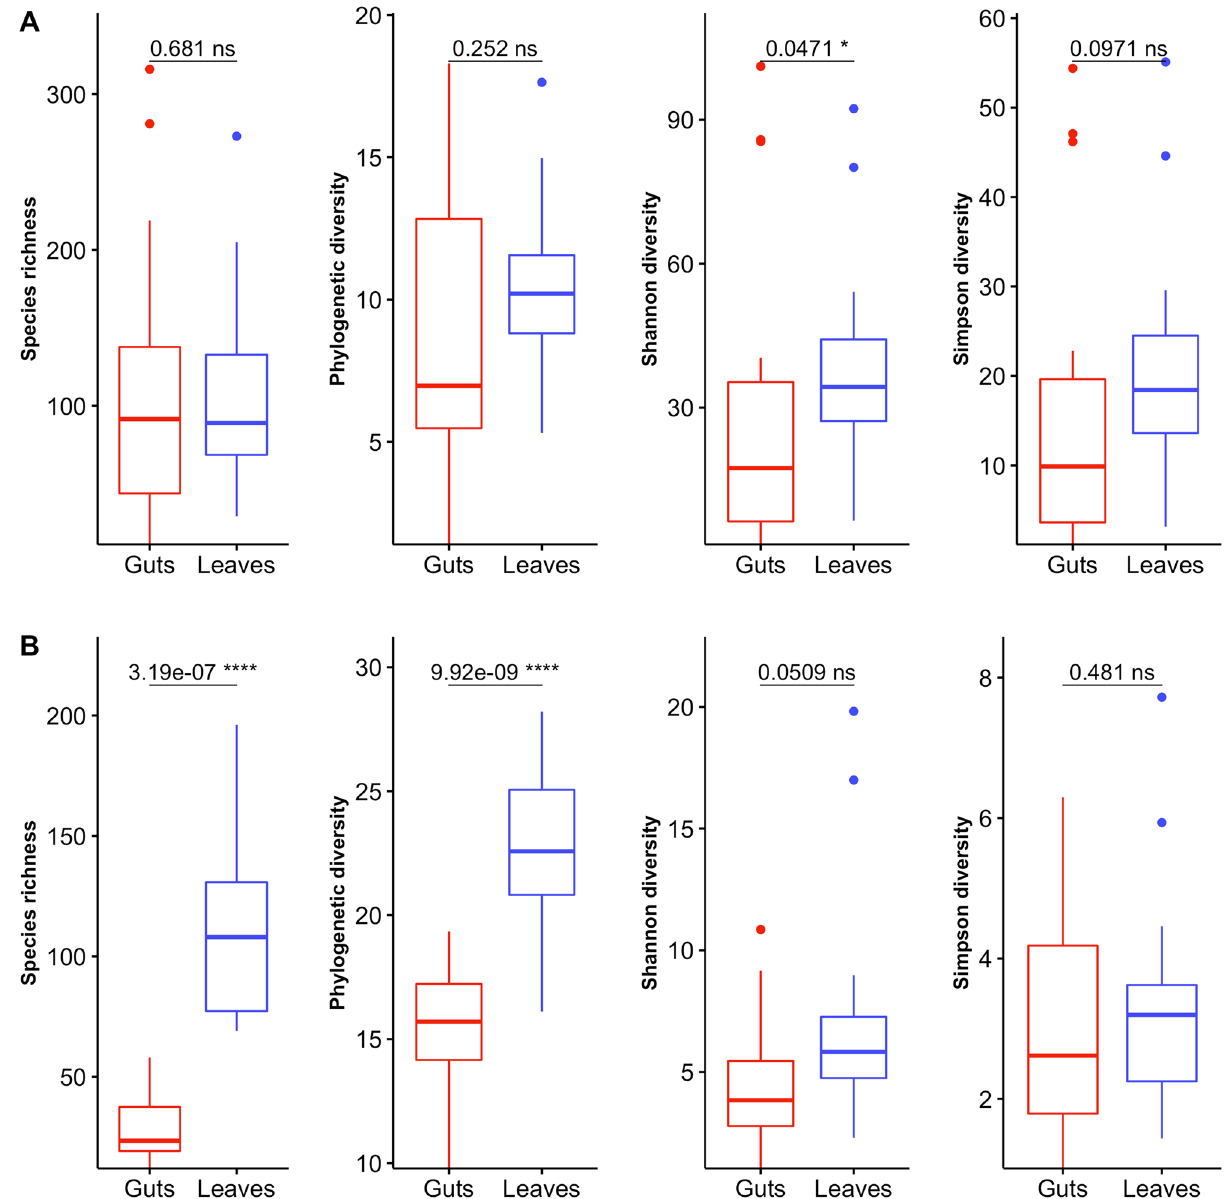
Figure 3. Species richness and diversity indices in the insect gut and on the leaves computed from raw data for communities of bacteria ( A ) and fungi ( B ). Values at the top of the panels: Wilcoxon signed-rank test statistics and significance: Significance codes: 0 ‘***’ 0.001 ‘**’ 0.01 ‘*’ 0.05 ‘NS’ >